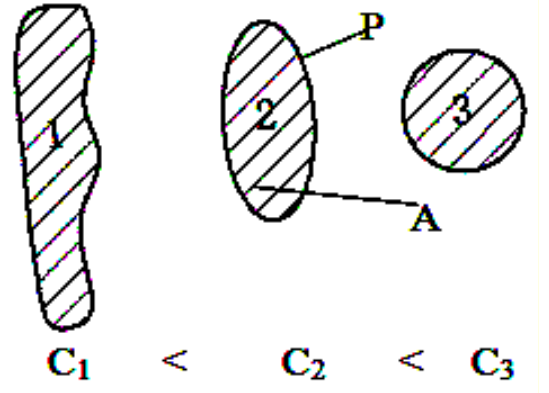
Figure 2. Schematic of the roundness of carbides.